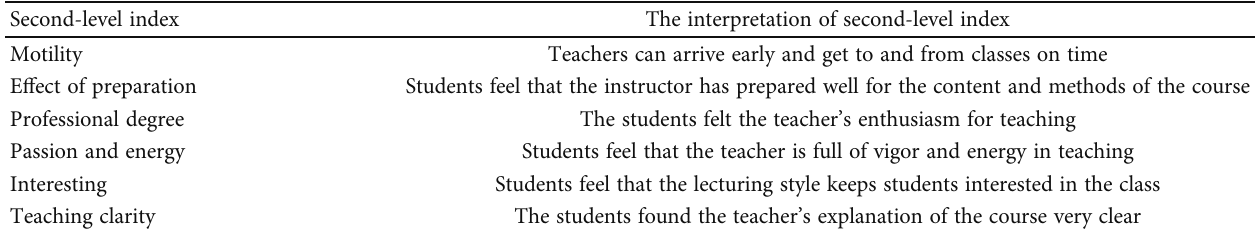
Table 11: Comprehensive evaluation index system of teaching reform projects ( fi rst-level index: teaching e ff ect of teachers).